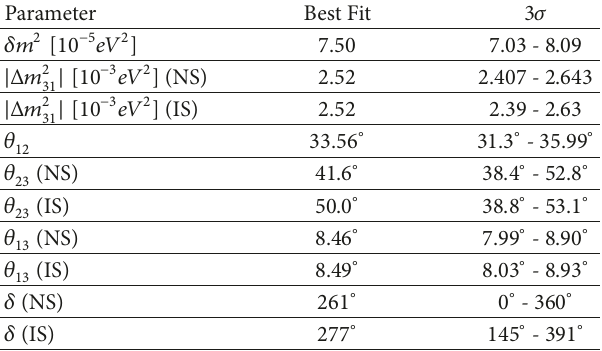
Table 1: Current neutrino oscillation parameters from global fits at 3 𝜎 confidence level (CL) [47, 48]. NS(IS) refers to normal (inverted) neutrino mass